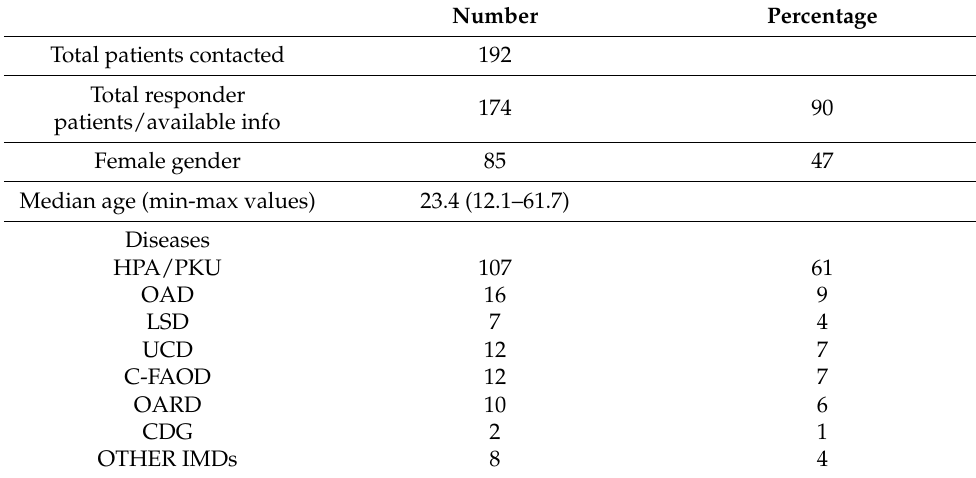
Table 1. Demographic characteristics of patients and